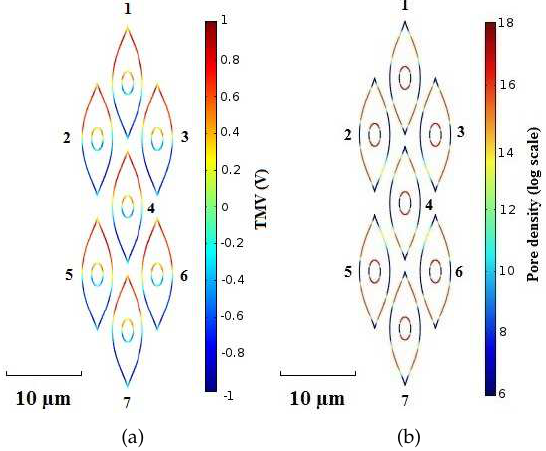
Figure 5. Packed System—( a ) TMV and ( b ) pore density distribution on cell membranes at time instant t = 20 ns. Pulse amplitude and duration equal to 100 kV/cm and 10 ns,